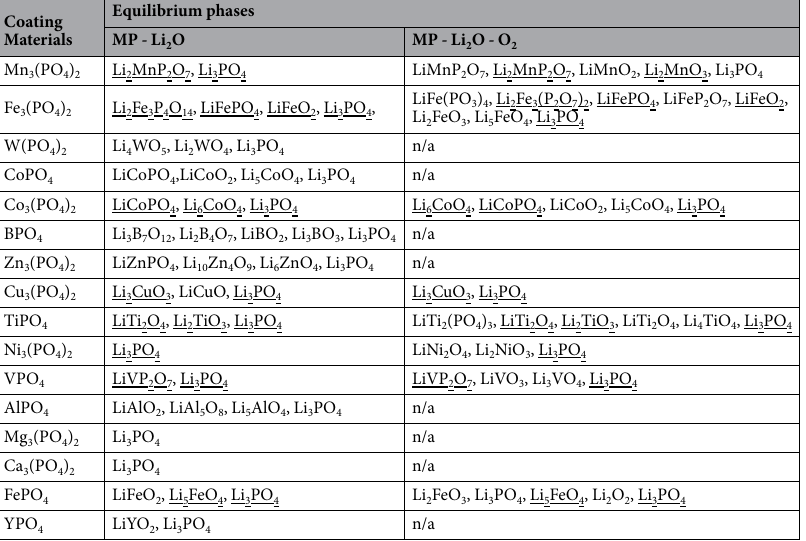
Table 2. Equilibrium phases formed from the reaction between MP-Li 2 O and MP-Li 2 O-O 2 based on phase diagrams. Underlined phases denote that they are found both with and without O 2